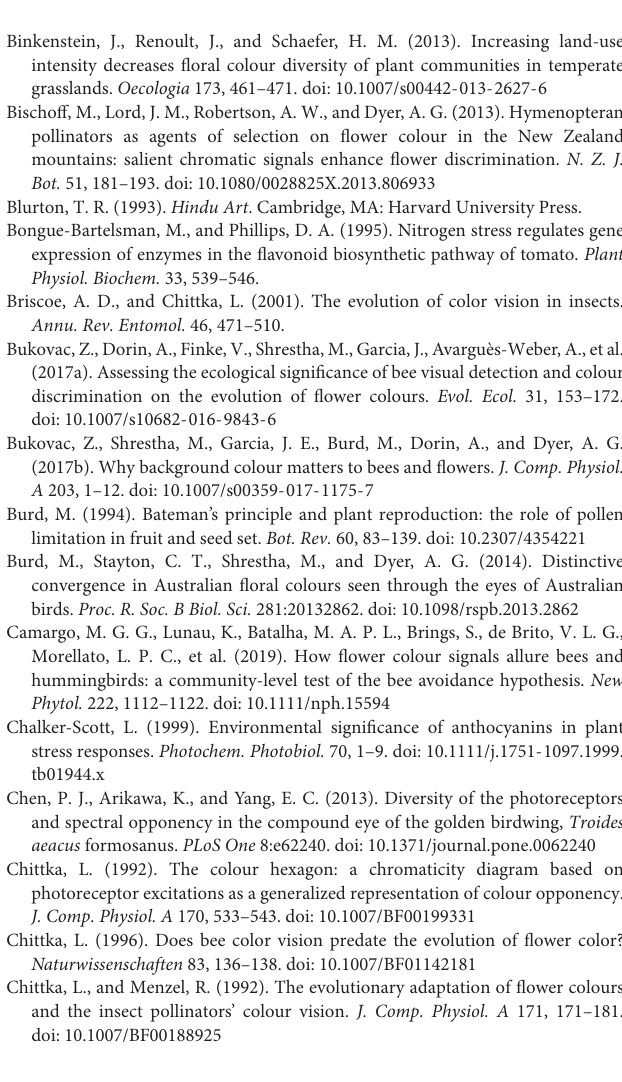
Supplementary Figure 1 | Global flower color frequency across species based on the human visual system Supplementary Appendix 1 | R code for Figure 1